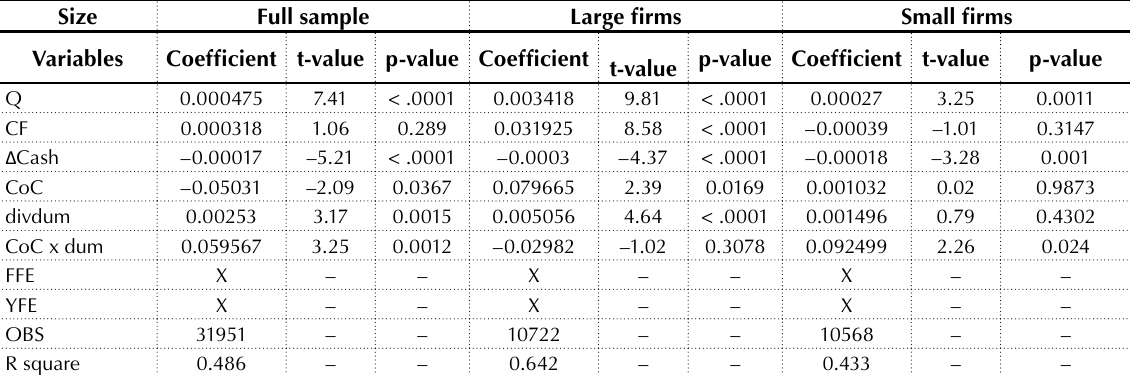
Table 6. Panel regressions with the cost of carry measure and dividend-related